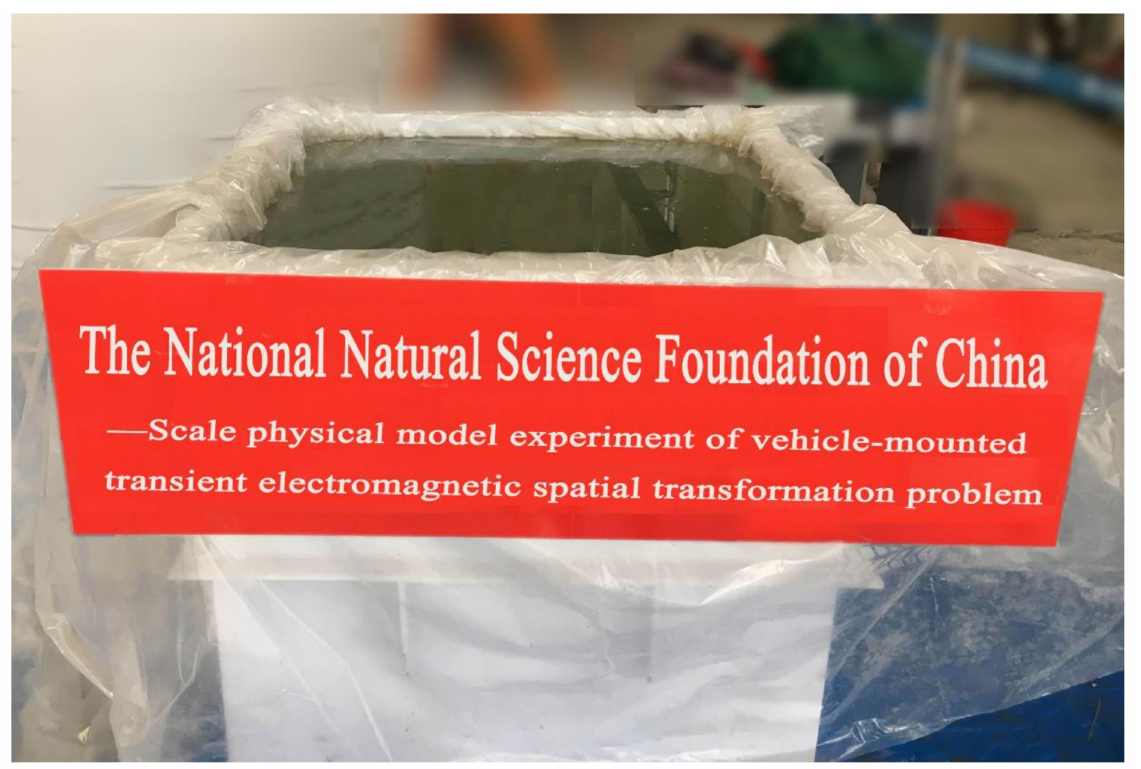
Figure 13. Schematic diagram of the indoor transient electromagnetic spatial transformation